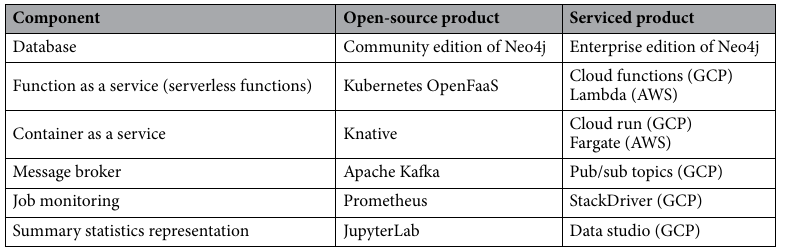
Table 1. Examples of open-sourced or managed services to implement the primary components of the Trellis model on both public and private cloud